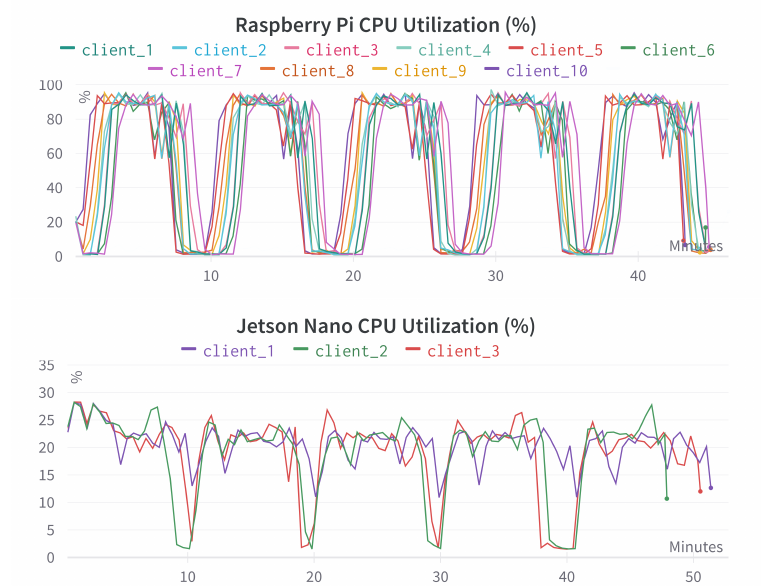
Figure 8. CPU utilization comparison for different Raspberry Pi and Jetson Nano devices. The x-axis represents the time in minutes, the y-axis represents the CPU utilization percentage